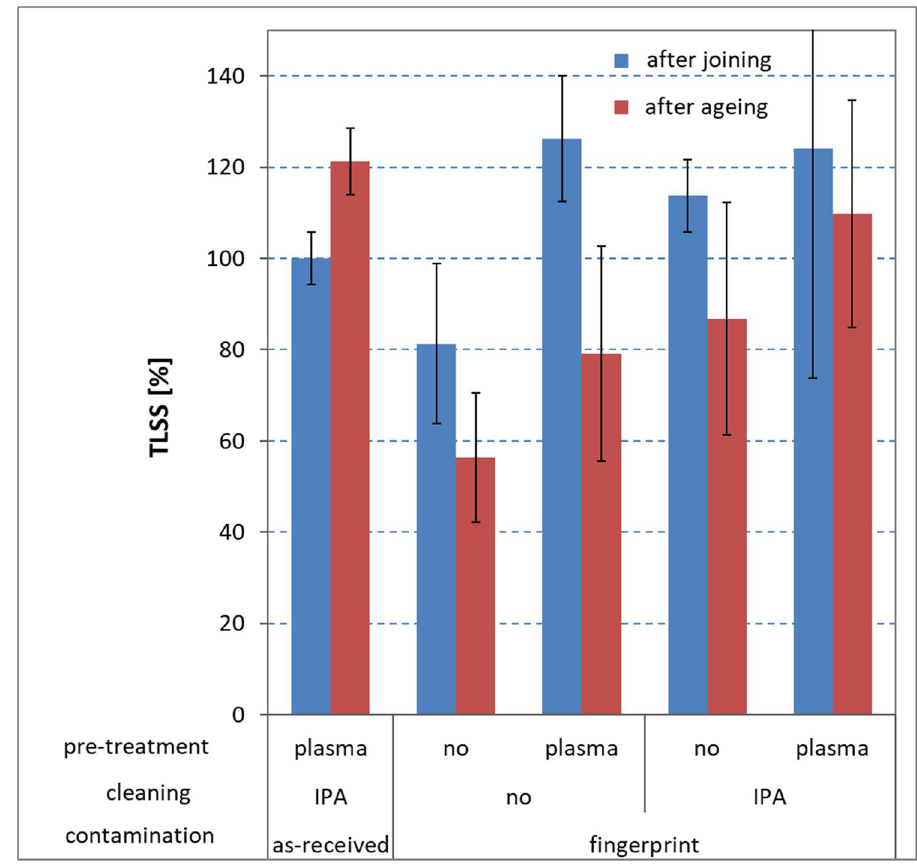
Fig. 6 Comparison of lap shear strength results obtained for aged (red columns) and non-aged (blue columns) lap shear samples for different sample sets prepared from green ABS-PMMA adherends with a fingerprint as a surface contamination in the bonding region. Different starting states of the adherend surfaces, optionally applying a cleaning step with isopropanol (IPA) and optionally performing surface pre-treatment with atmos- pheric pressure plasma (APP) treatment are